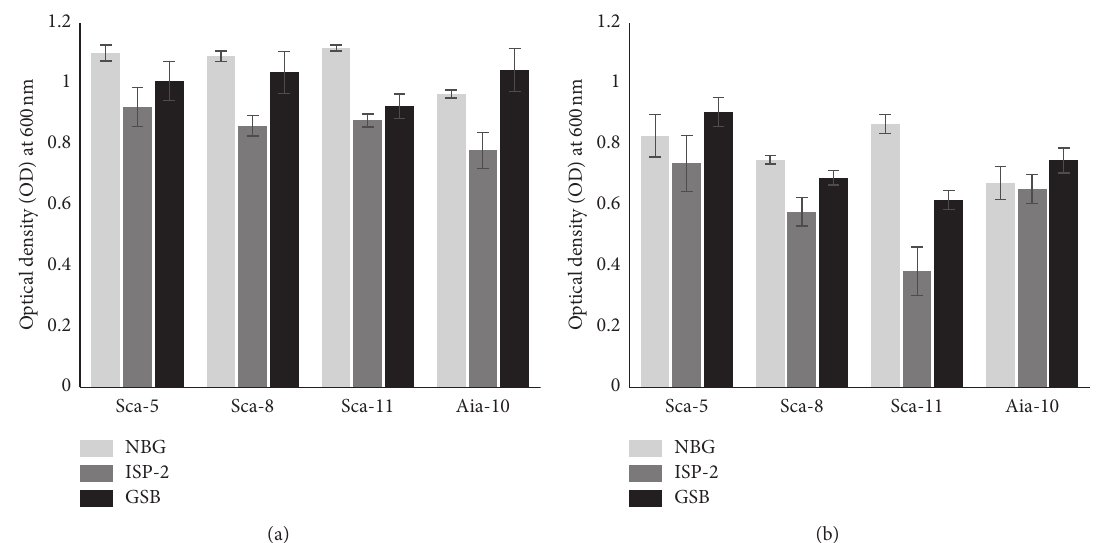
Figure 4: The OD values at 600nm of (a) Escherichia coli and (b) Staphylococcus aureus growth exposed to the supernatant of isolates that were grown in NBG (nutrient broth glucose) broth, ISP-2 (yeast-malt extract) broth, and GSB (Gause synthetic)